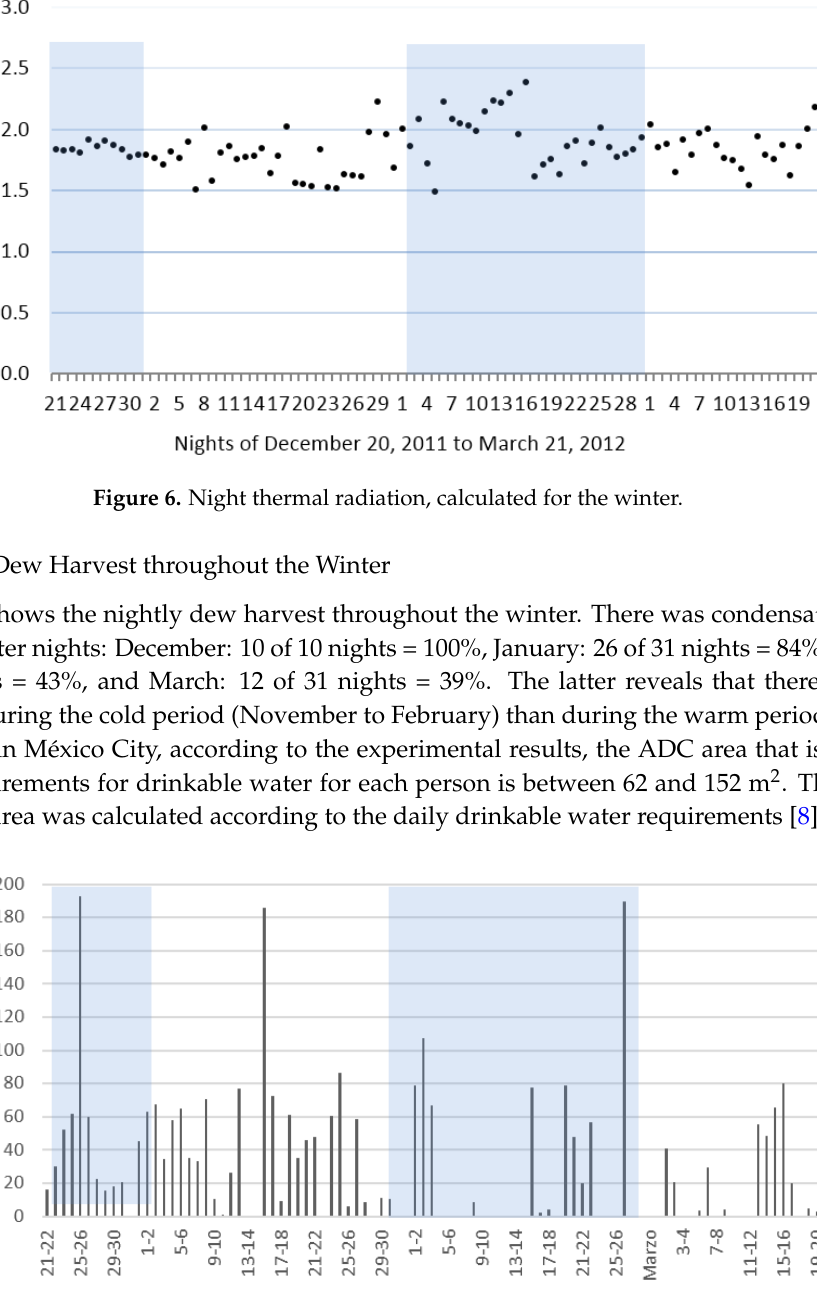
Figure 4. Hourly dew harvest and weather conditions during a representative night. Figure 5. Hourly dew harvests during eight clear sky nights.